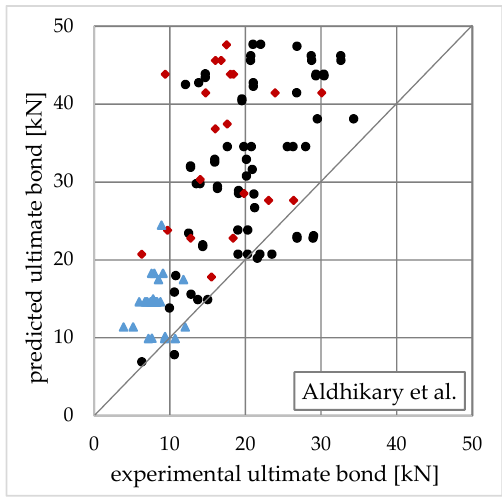
Figure 14. Test vs. predicted bond force using the Adhikary et al. model [26]. Appl. Sci. 2020 , 10 , 8593